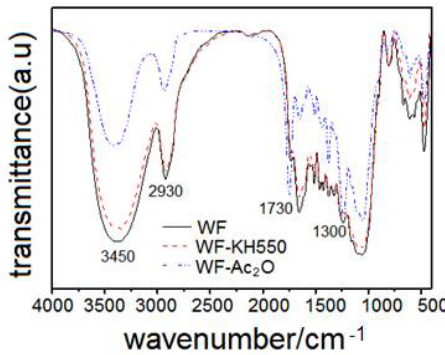
Figure 1. FTIR spectra of WF before and after pretreatment.